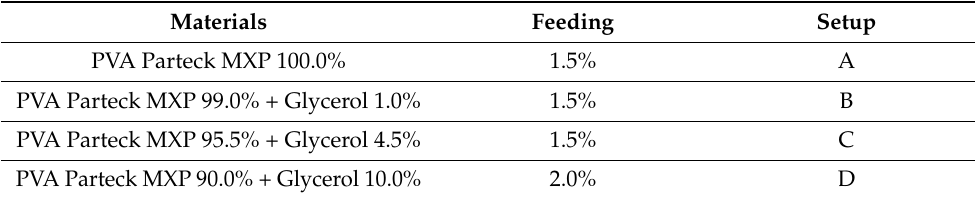
Table 1. Composition and feeding rate of the feeder in the production of different batches of fiber and yarn material from polyvinyl alcohol and glycerol. Materials Feeding Setup PVA Parteck MXP 100.0% 1.5% A PVA Parteck MXP 99.0% + Glycerol 1.0% 1.5% B PVA Parteck MXP 95.5% + Glycerol 4.5% 1.5% C PVA Parteck MXP 90.0% + Glycerol 10.0% 2.0% D